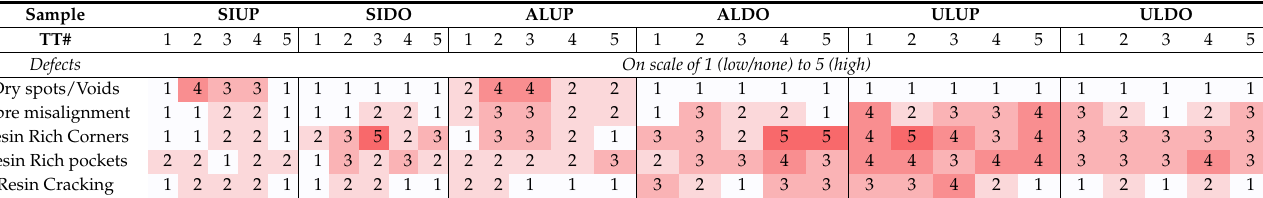
Table 4. Map of defects observed TT on parts from scanned